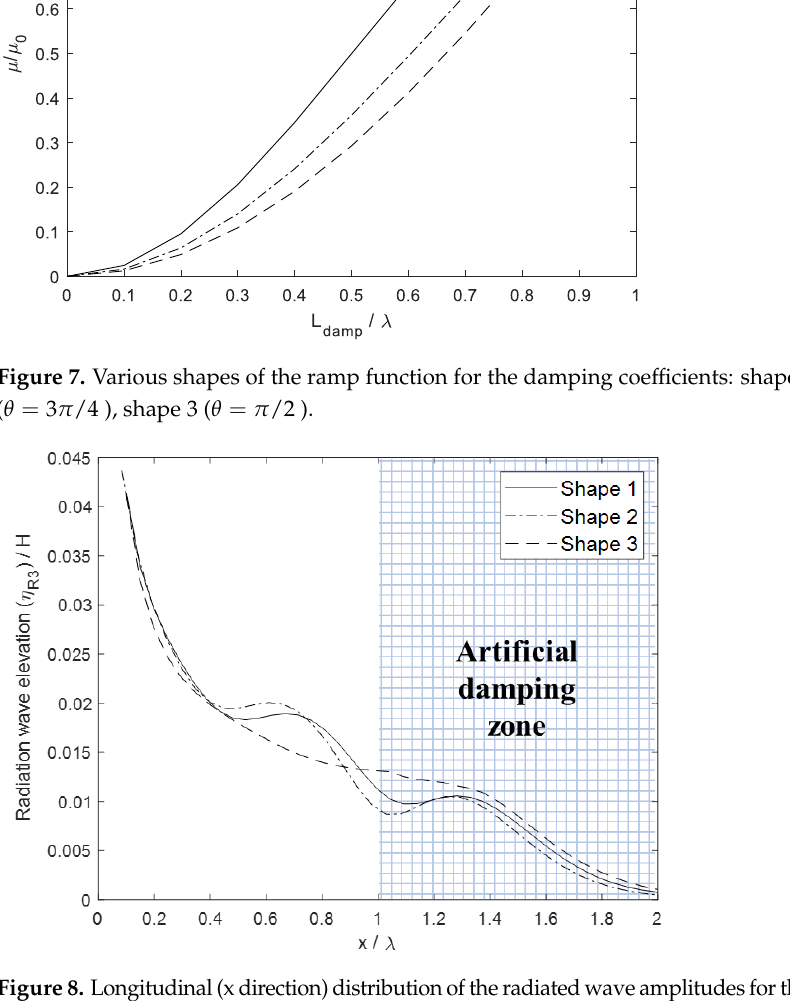
( b ) Figure 10. Radiated wave amplitude distribution on the free surface using ADZ: ( a ) low wave fre- quency ( 𝜔 = 1.5 rad/s) ; ( b ) high wave frequency ( 𝜔 = 3.0 rad/s) A parametric study of the damping coefficients was conducted. For this analysis, the radiation problem was performed with various damping coefficients in 𝜔 = 1.5 and 3.0 rad/s , as shown in Figure 11. The results were compared with those of WAMIT. When the artificial damping coefficient is more than 2.0, the heave-added mass and damping coefficient converged and agreed well with the WAMIT results. Another parametric study on the length of the ADZ was performed (Figure 12). The combined radiation boundary condition (SRC and ADZ) was employed to re- duce the length of the ADZ, and the corresponding results were compared with those obtained when only the ADZ was applied. When the length of the ADZ was longer than one wavelength, the results of FR-NWT showed good agreement with those of WAMIT, as suggested in previous studies [22,31,32].